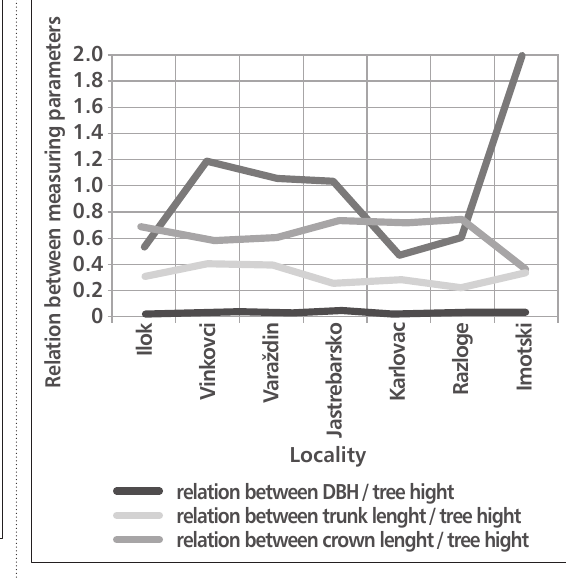
Locality relation between DBH / tree hight relation between trunk lenght / tree hight relation between crown lenght / tree hight Important tree measuring parameters of the selected Horse chestnut trees Relations of the Horse chestnut tree measuring parameters The selected trees differed mostly in tree height while The results of the measured annual shoot parameters the least differences were found in crown width (Graph are displayed in Table 3. The greatest difference 1). Differences were evident also in the relation between was recorded in the number of leaves and the least crown width and crown length, the least differences in difference in the annual shoot diameter (Graph 3). the DBH/ tree height ratio (Graph 2). The measured leaf parameters are displayed in Table 4, the longest leaf was recorded in Razloge and the shortest in Jastrebarsko. Also the leaves in Jastrebarsko Locality shoot lenght sverage interdnodium space shoot diameter number of internodium number of leaves FIGURE 3 Horse chestnut annual shoot parameters